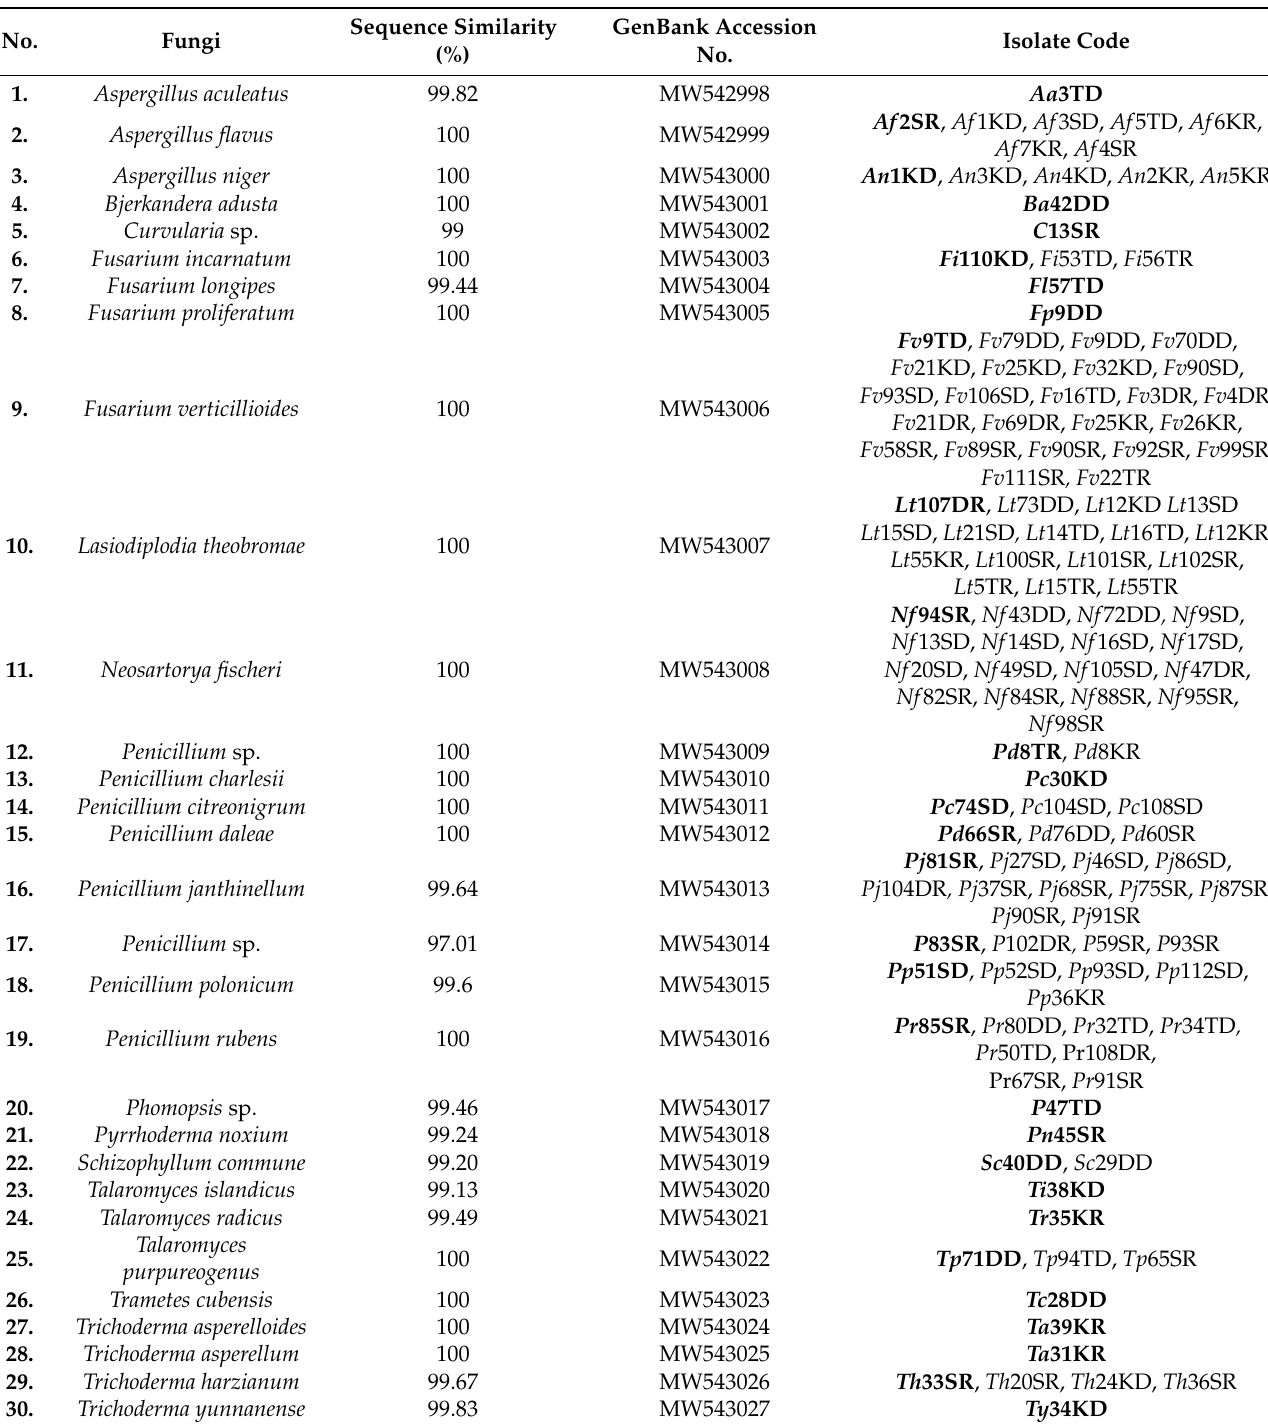
Table 2. Fungal species, sequence similarity (%), GenBank accession number, and isolate code of fungal isolates obtained from Kampong Dadong and Rhu Tapai grain corn farms in